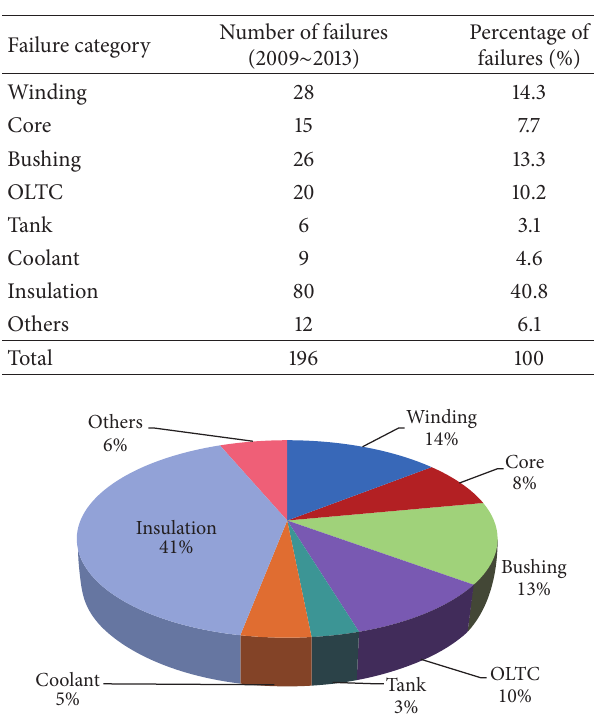
Table 8: Power transformer failures based on the components during 2009 ∼ 2013.